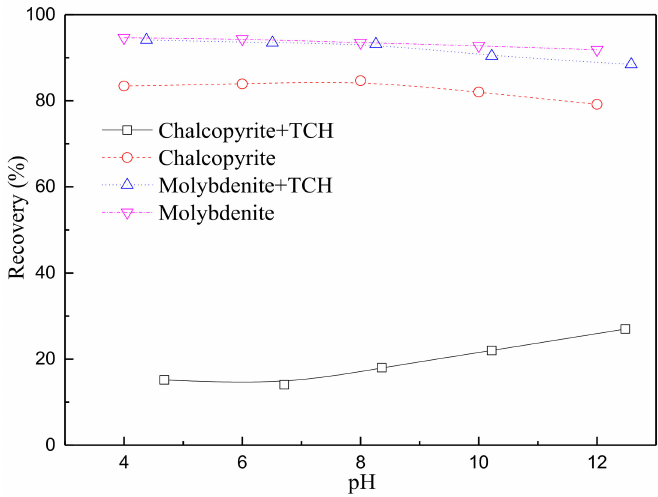
Figure 2. Influence of pH on floatability of chalcopyrite and molybdenite with or without